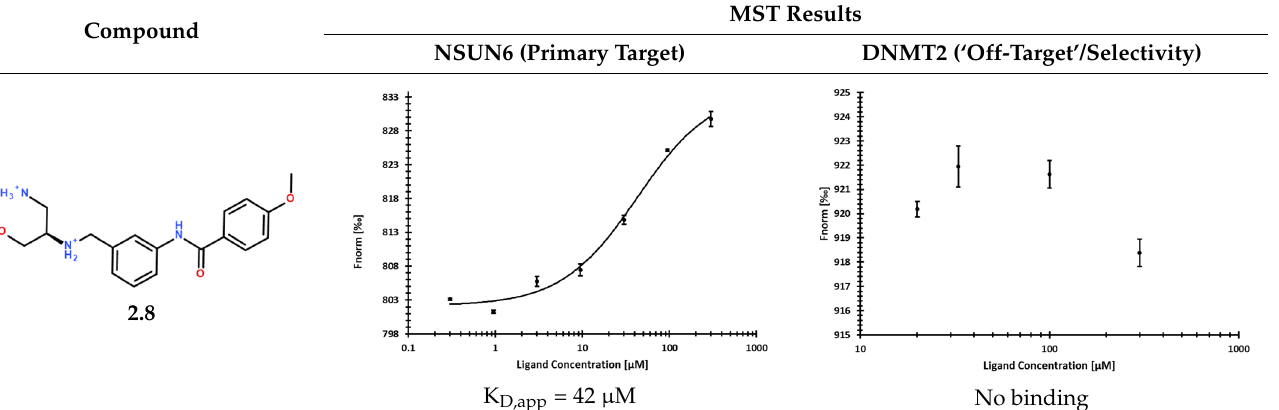
For DNMT2 hits (Table 2), regularly observed features in predicted binding modes were mimics of the H-bond acceptor pro fi le of SAM’s methionine amino acid carboxylate sub-structure. While not necessarily being charged, for 1.4 (Figure 4A), instead of the docked and depicted protomer, a phenolate anion also seems reasonable due to the vi- nylogous acid with a predicted pK a of 7.04 (calculated with MOE). More often, H-bond acceptors were found in a heterocycle-like triazine ( 1.17 and 1.18 ) or oxadiazole ( 1.6 ). A mimic of the native ligand’s basic, primary amine, however, was not found in the virtual screening hits. Connected by di ff erent types of linkers, the ribose hydroxy groups are re- placed by either a urea ( 1.4 , Figure 4A), an amide ( 1.6 , 1.14 ), or a basic nitrogen ( 1.17 , 1.18 , Figure 4B) to interact with Asp-34. Lastly, the natural ligand’s adenine moiety and its H- bond interaction pro fi le with Glu-58 and Ile-57 (Figure 3A) can be mimicked by an analog 4-amino quinazoline ( 1.14 ), an amide either a tt ached to ( 1.6 ) or part of ( 1.4 , Figure 4A) a ring system, or by a 3,5-dimethyl-1 H -pyrazole ( 1.17 , 1.18 , Figure 4B).